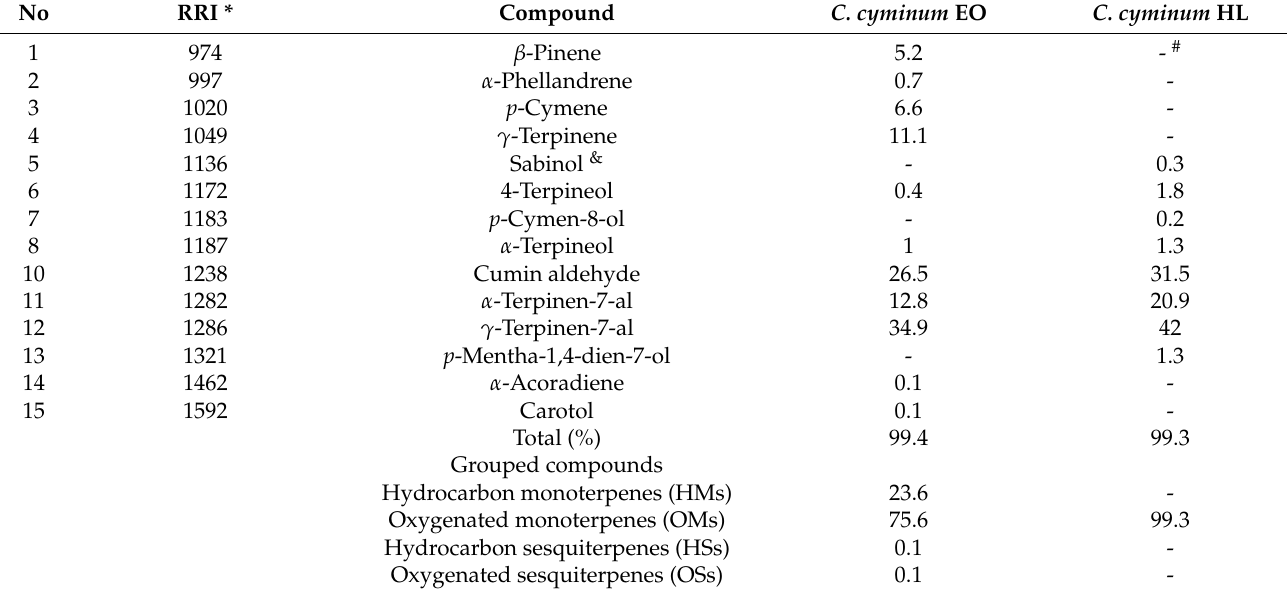
Table 1. Chemical composition of the essential oil (EO) and hydrosol (HL) of Cuminum cyminum